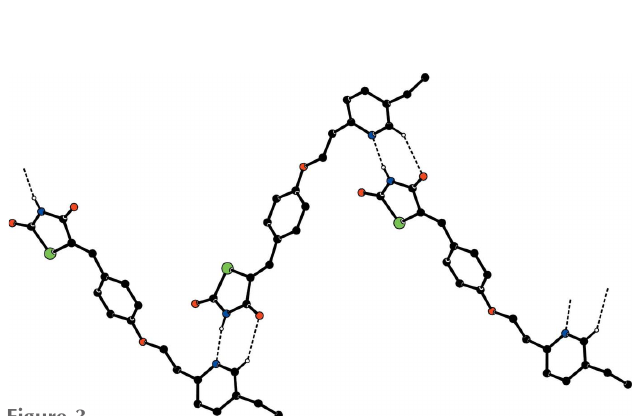
(7) graph-set motif. 2